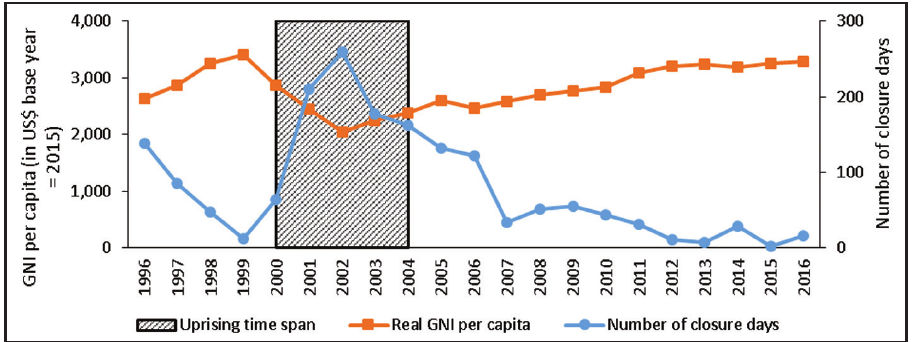
Figure 1 Evolution of Palestinian real GNI per capita (in constant 2015 US$) and the number of closure days, 1996–2016